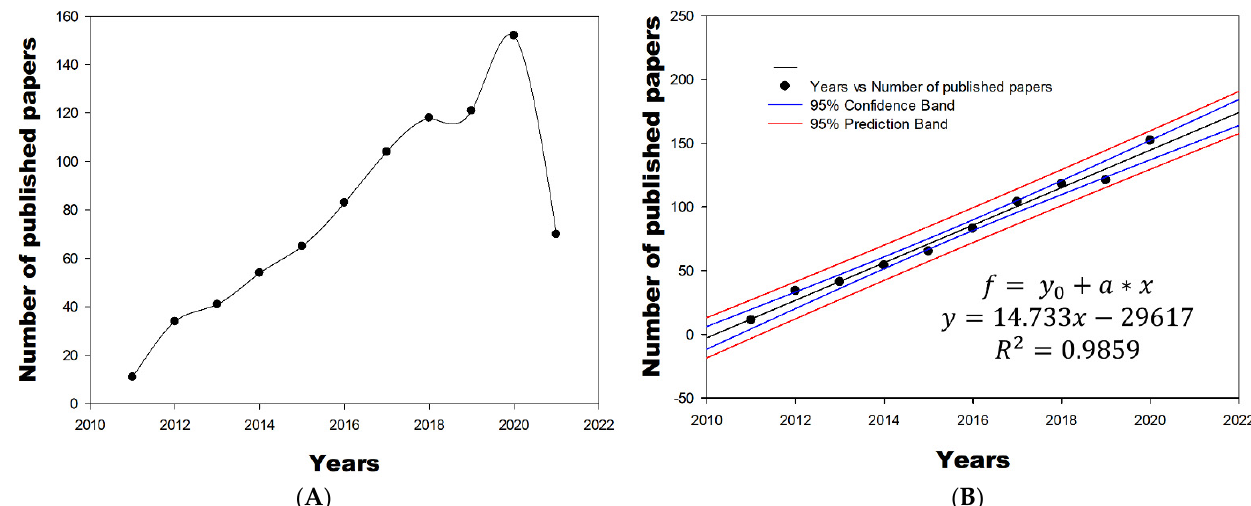
Figure 1. ( A ) Number of articles in Scopus from 2011 to 2021 in the field of the use and applications of postharvest chitosan products. ( B ) Fitted linear trend for the number of publications.